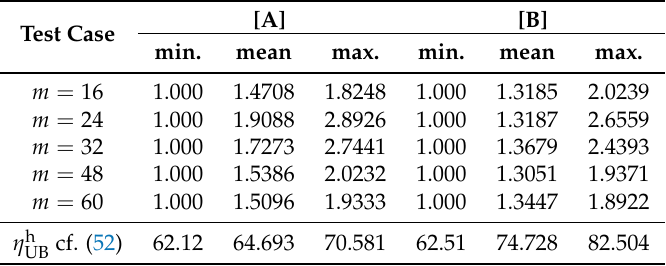
Table 2. Computed values of η ( p ) for different modes sets and for test cases [A] , [B] ; the last row η ( p ) represents the upper bound η h UB ≥ Test